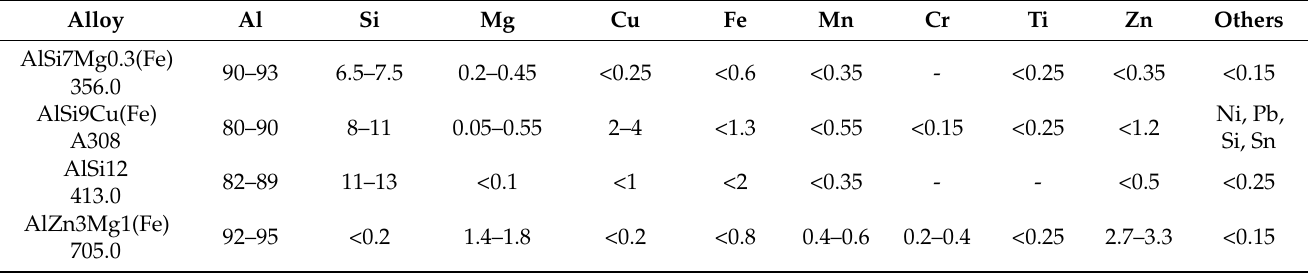
Table 2. Chemical composition (in wt.%) of commonly used SAAs [56].